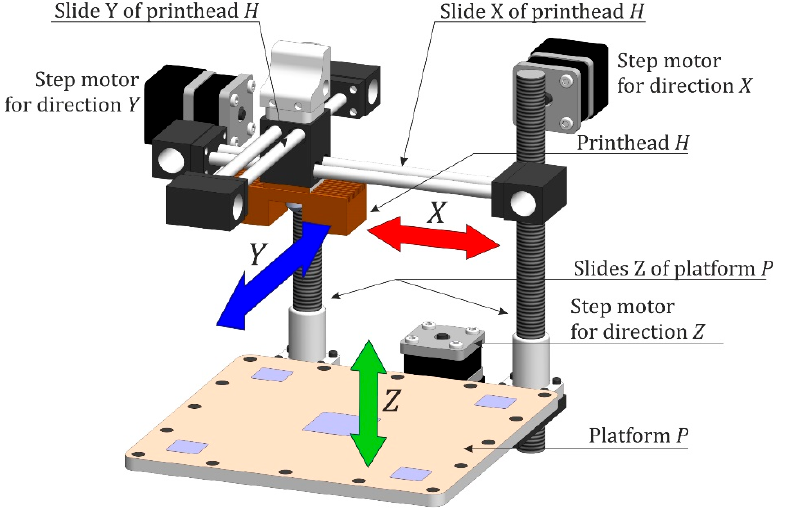
Figure 1. The directions of printhead and platform movements.